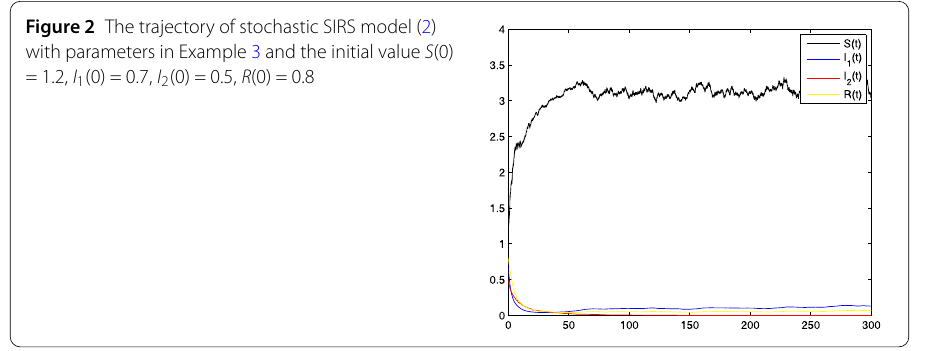
Figure 2 The trajectory of stochastic SIRS model (2) with parameters in Example 3 and the initial value S